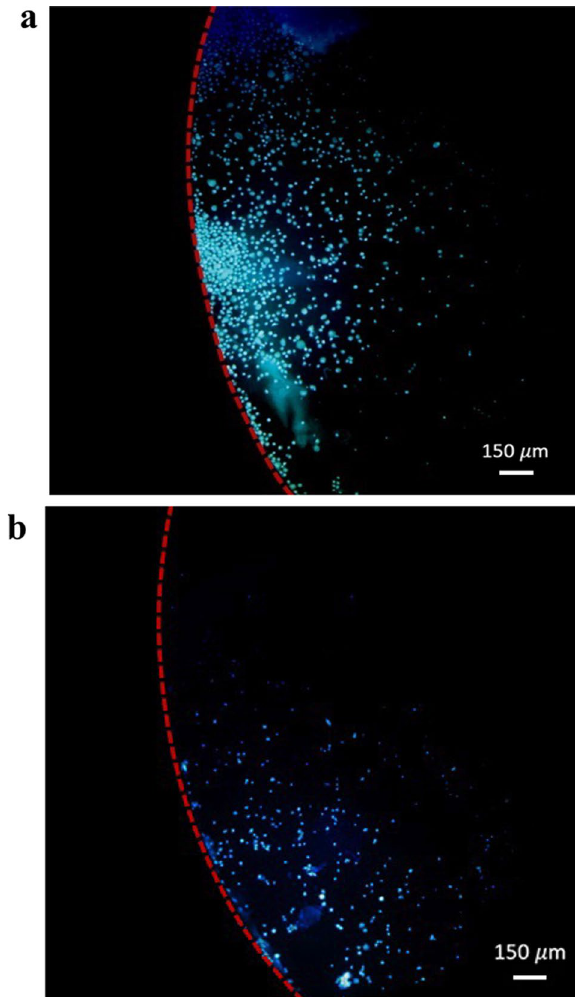
Figure 8. Fluorescent images of MCF-7 cells captured by the passive centrifugal separator at the rotational speed of 2100 rpm. ( a ) Target chamber. ( b ) Non-target